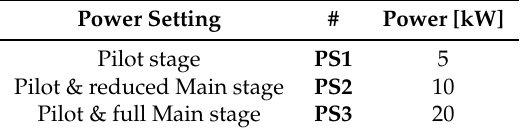
Figure 19. Intensities in RGB as a function of the flame operation. Table 4. Combustion test rig power levels achieved under p = 2.3 bar